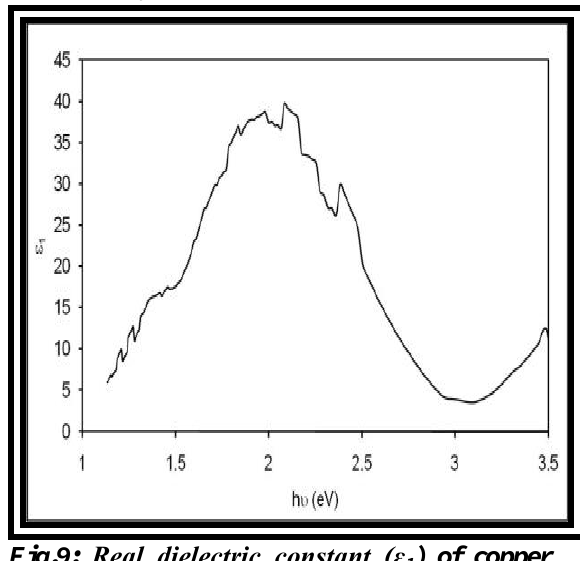
Fig.9: Real dielectric constant (ε oxide thin film.